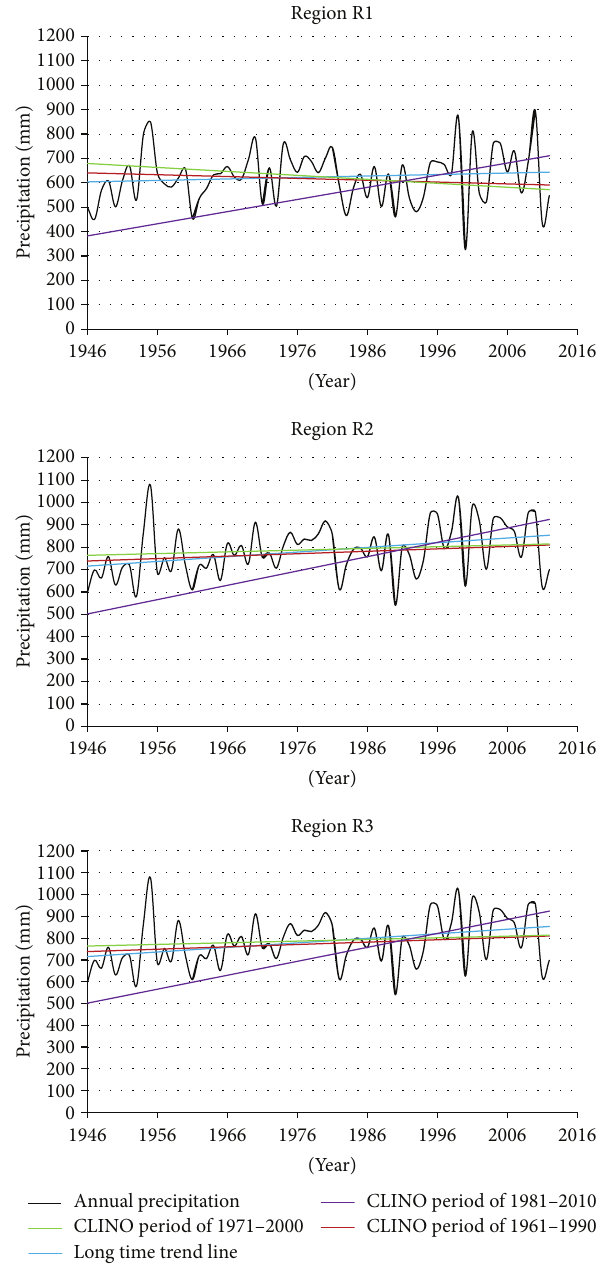
Figure 5: The trend of annual precipitation by regions.